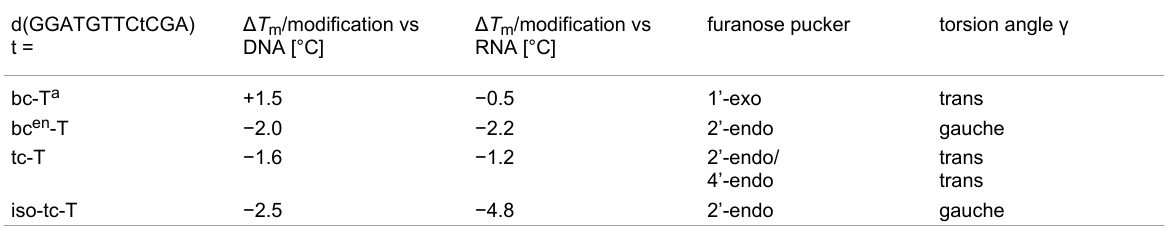
Table 3: Δ T m /modification data for four different bi/tricyclo modifications in one sequence context. d(GGATGTTCtCGA) Δ T m /modification vs t = DNA